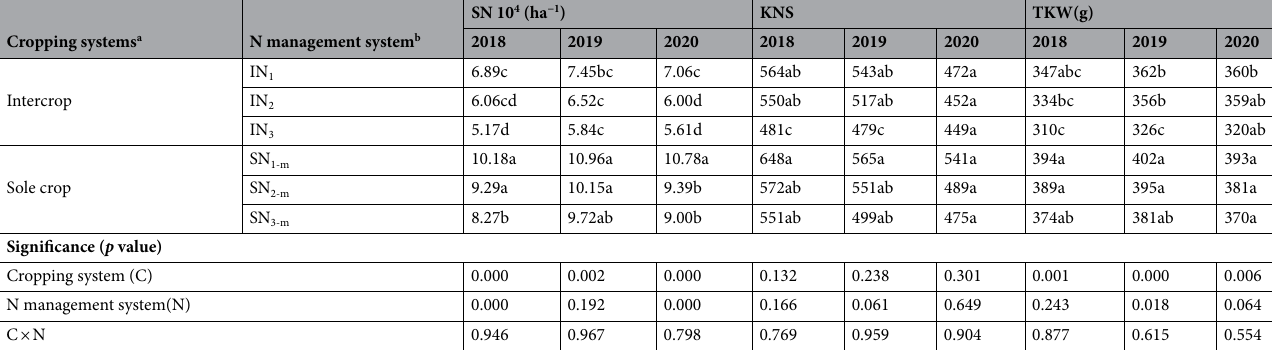
Table 4. The spike number (SN), kernel number per spike (KNS), and thousand-kernel weight (TKW) of maize in sole crop and intercrop as affected by cropping system and N management in 2018–2020. Means with the same lowercase letters in the same column are significantly different at P < 0.05. a Intercrop and sole crop means the intercropped maize and sole maize. b For intercropping, N 1 , N 2 , and N 3 represent N-fertilizer applied at 51, 72, and 93 kg N ha −1 as first top-dressing plus 63, 42, and 21 kg N ha −1 at third top-dressing, respectively. For sole cropping, N 1 , N 2 and N 3 represent N-fertilizer applied at 36, 72, and 108 kg N ha −1 as first top-dressing plus 108, 72, and 36 kg N ha −1 at third top-dressing, respectively.